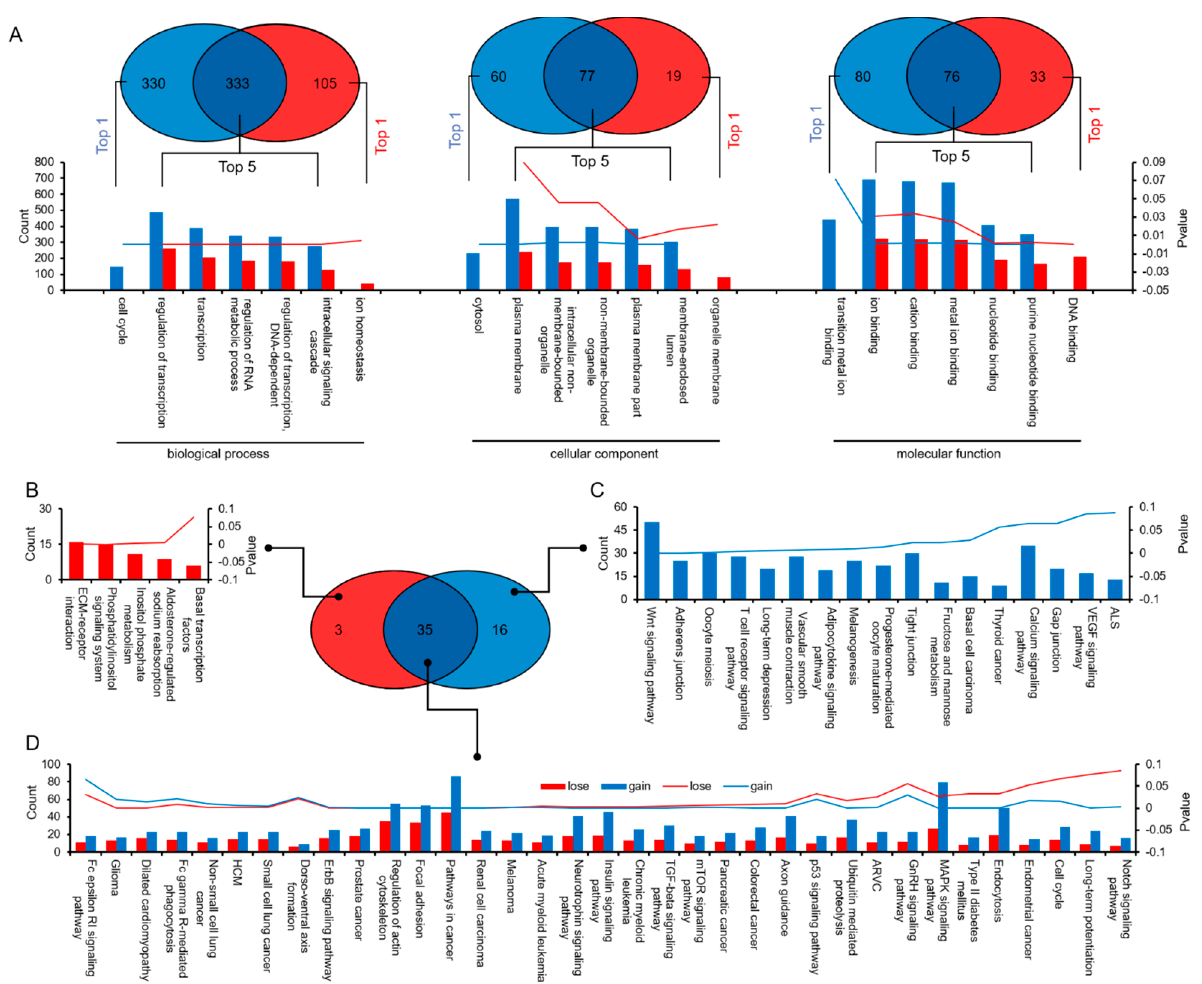
Figure 4. Prediction of miRNA target genes and analysis of GO and KEGG pathways based on expression difference percentage. ( A ) GO analysis of the target genes for lose/gain miRNAs. ( B ) KEGG annotation enrichment of target genes for lose/gain miRNAs.